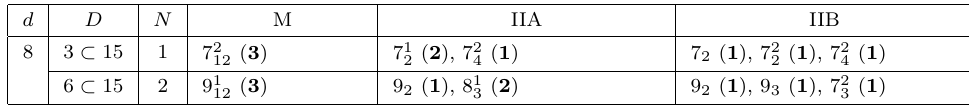
Table 22 . Missing states in the 7-brane